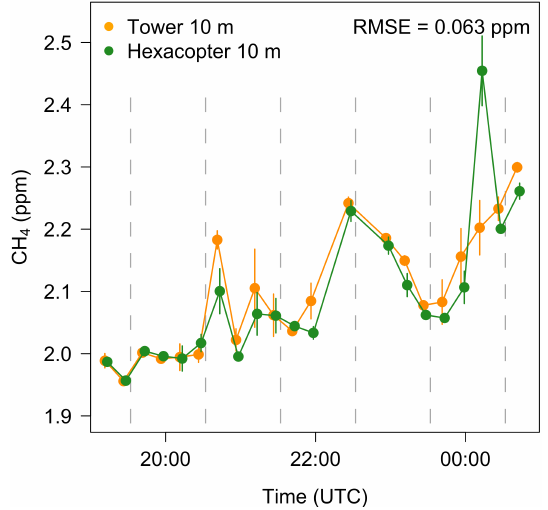
Figure 7. Methane mixing ratio measured at the tower and with the multicopter on the night between 21 and 22 July 2015. Tower data were measured just before the 10m data from the multicopter. Error bars show the standard deviation for each measurement averaged over 60s. A standard deviation of 0.01ppm or less cannot be shown because the size of the data point exceeds the error bar. The dashed grey lines represent the time for which vertical profiles are shown in Figs. 8 and 9. Local time (CEST) is UTC +